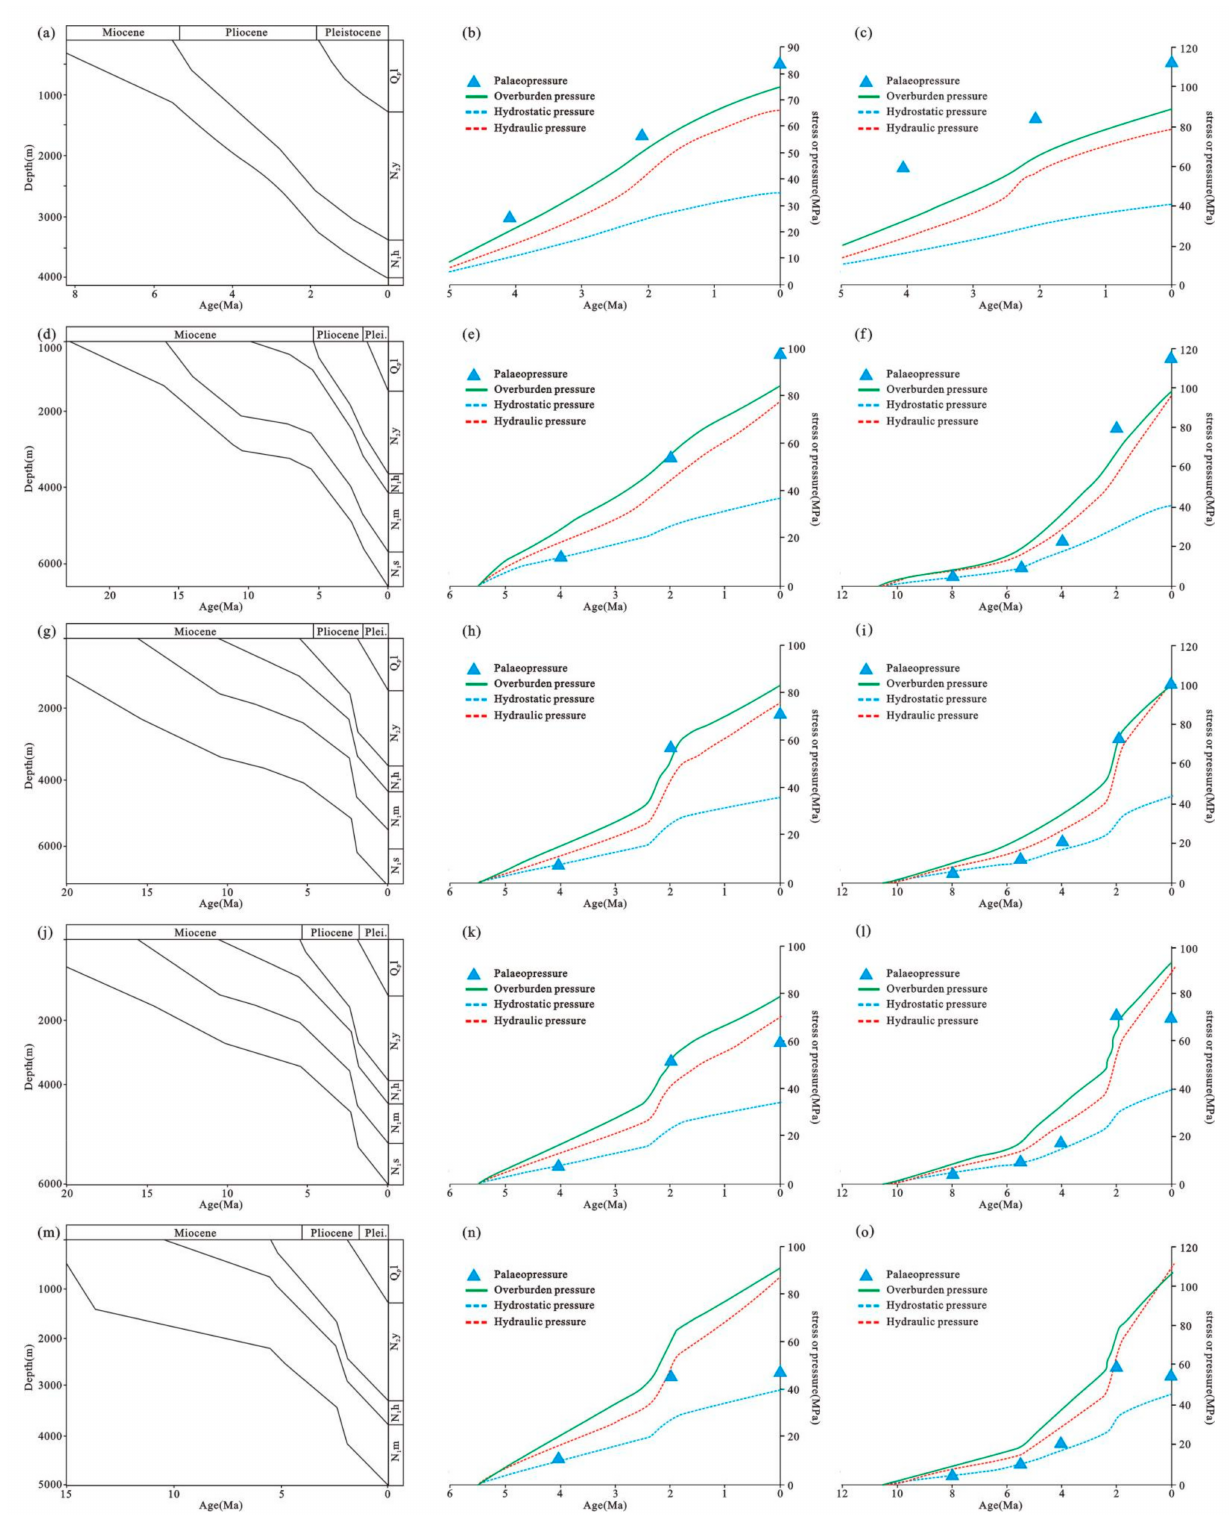
Figure 11. Burial history of the five blocks in study area and the hydraulic risk analysis of Huangliu and Meishan Formation in geological time. ( a – c ) is the XD-A, the palaeopressure was larger than the hydraulic, indicating continuous leakage in whole geological time in both Huangliu and Meishan Formation. The Xd-B show in ( d – f ) is similar to the XD-A, the leakage time was later than XD-A, and still leaking today. ( g – i ) and ( j – l ) is present XD-C and XD-D block, hydraulic fracture occurred about 2 Ma. ( m – o ) is the XD-E which is farthest from the diapir, has not reached the hydraulic fracture pressure in the historical period until